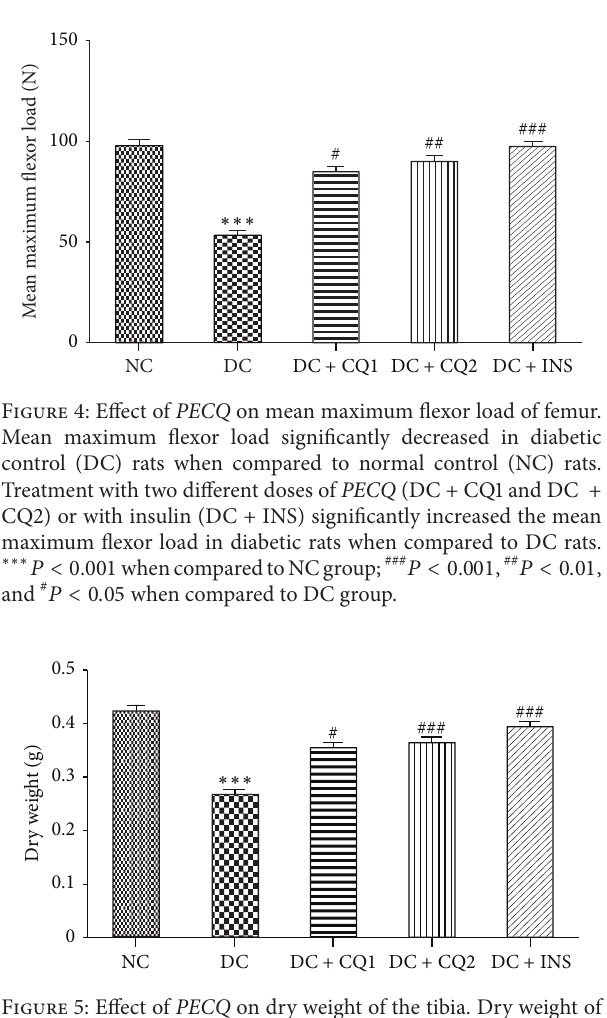
Figure 5: Effect of PECQ on dry weight of the tibia. Dry weight of the tibia significantly decreased in diabetic control (DC) rats when compared to normal control (NC) rats. Treatment with two different doses of PECQ (DC + CQ1 and DC + CQ2) or with insulin (DC + INS) significantly increased the dry weight in diabetic rats when compared to DC rats. ∗∗∗ 𝑃 < 0.001 when compared to NC group; ### 𝑃 < 0.001 , # 𝑃 < 0.05 when compared to DC